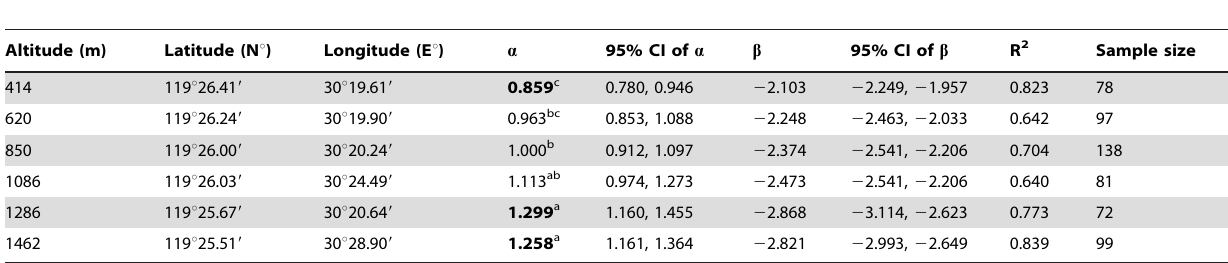
Table 1. Scaling exponents ( a ) and intercepts ( b ) of M-A relationship at six altitudes as estimated by RMA regression.